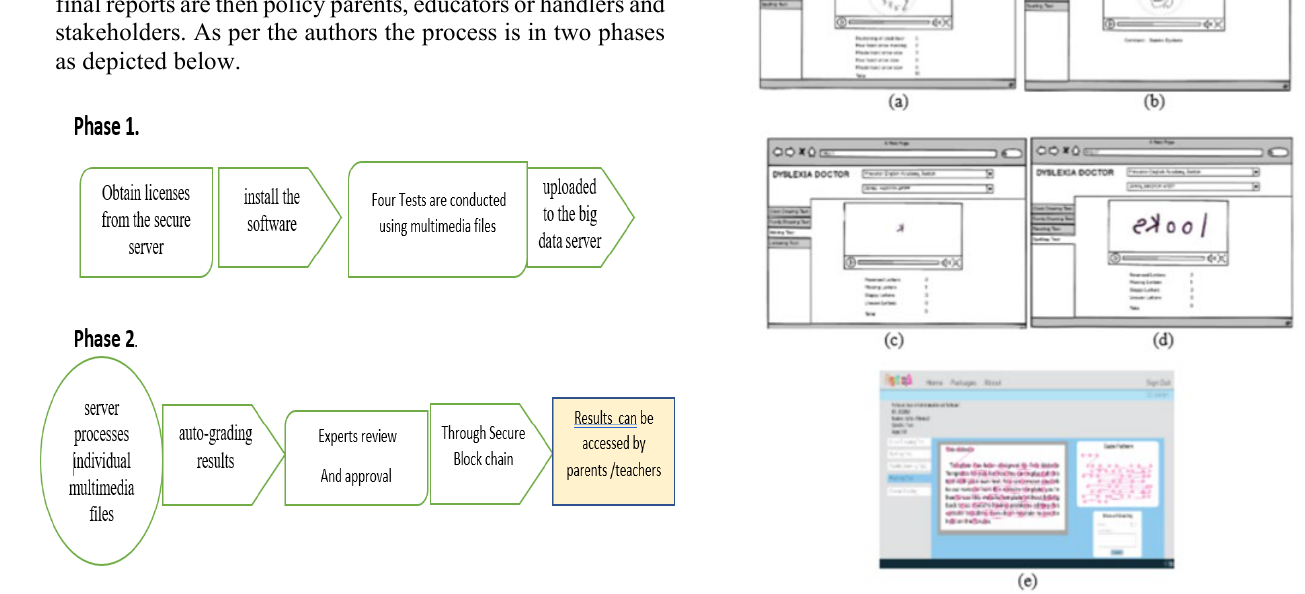
Figure 3. Various steps in generating results for LD